Question: Describe this figure in one sentence.
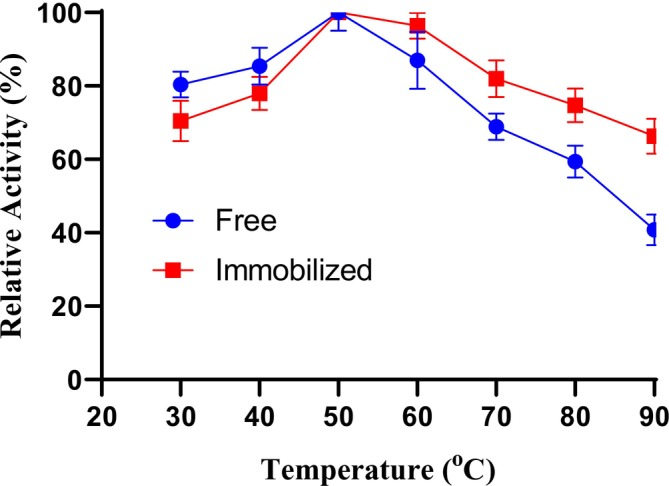
Answer: The effect of temperature on the relative activity of free and immobilized pectinase (data are presented as mean ± SD of triplicates).